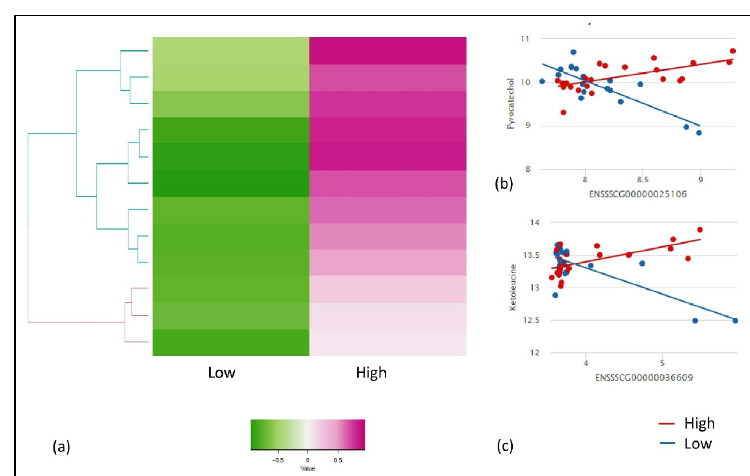
Figure 3. Results of IntLIM applied to FE-specific groups. ( a ) Clustering of 12 identified gene- metabolite pairs (FDR adjusted p -value of interaction coefficient < 0.1, Spearman correlation difference > 0.1 in high and low FE groups, ( b ) Gene-metabolite difference in ENSSSCG00000025106 ( THNSL2 )— Pyrocatechol (FDR adjusted p -value = 0.06, High-FE Spearman correlation = 0.6, Low-FE Spearman correlation = −0.7), ( c ) Gene-metabolite difference in ENSSSCG00000036609 ( TBXT )—ketoleucine (FDR adjusted p -value = 0.08, High-FE Spearman correlation = 0.5, Low-FE Spearman correlation = −0.3).